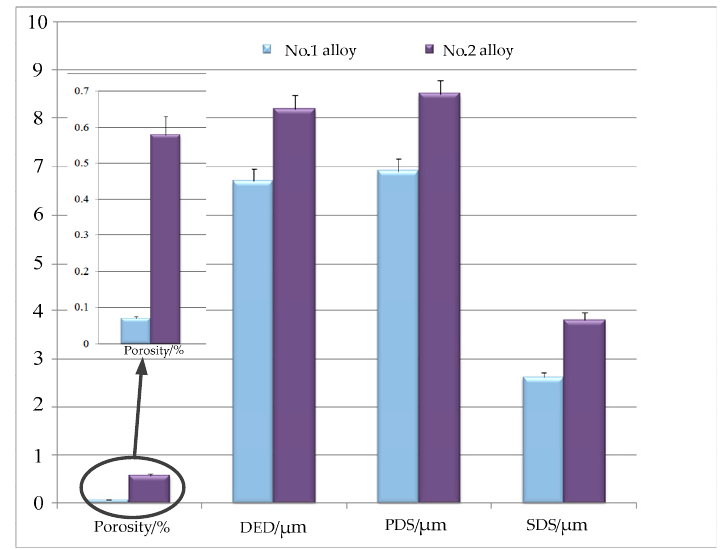
Figure 6. Comparison of macroscopic and microscopic morphology of two alloys.